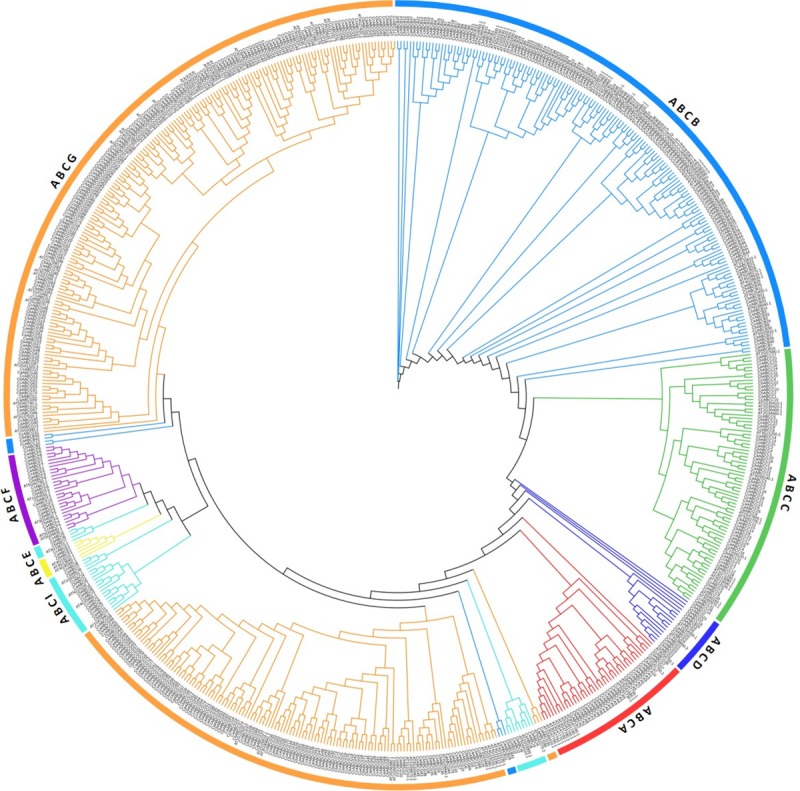
Phylogenetic relationships of Capsicum species and Arabidopsis ABC transporter proteins.The 572 and 119 ABC proteins identified from Capsicum species and Arabidopsis, respectively, were subjected to phylogenetic analysis by the neighbor-joining method with 1000 bootstrap replicates. Subfamily names (ABCA-I, except ABCH) are indicated by different colors.